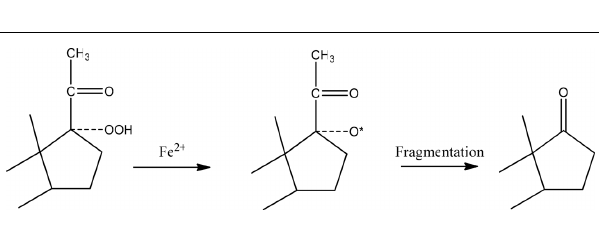
FIGURE 2 | Mechanism of ketone formation from hydroperoxides. This scheme illustrates how the addition of FeSO 4 could reduce the 17-hydroperoxide of PREG to an intermediate alkoxy radical. Cleavage of the two-carbon side-chain by b-fragmentation results in the formation of